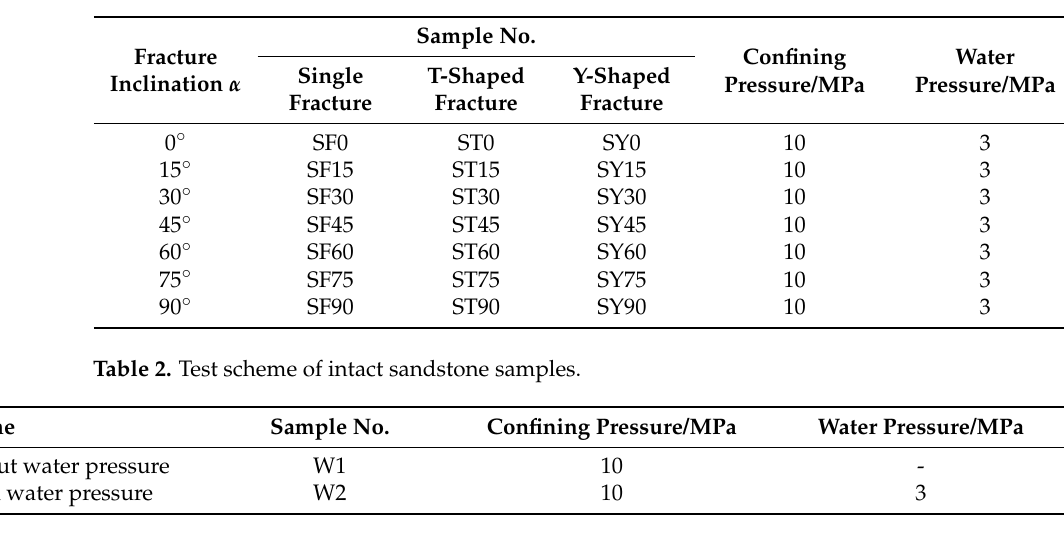
Table 1. Test scheme of fractured sandstone samples.